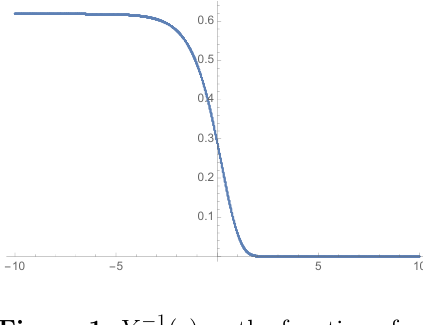
Figure 1 . Y − 1 ( s ) as the function of s R